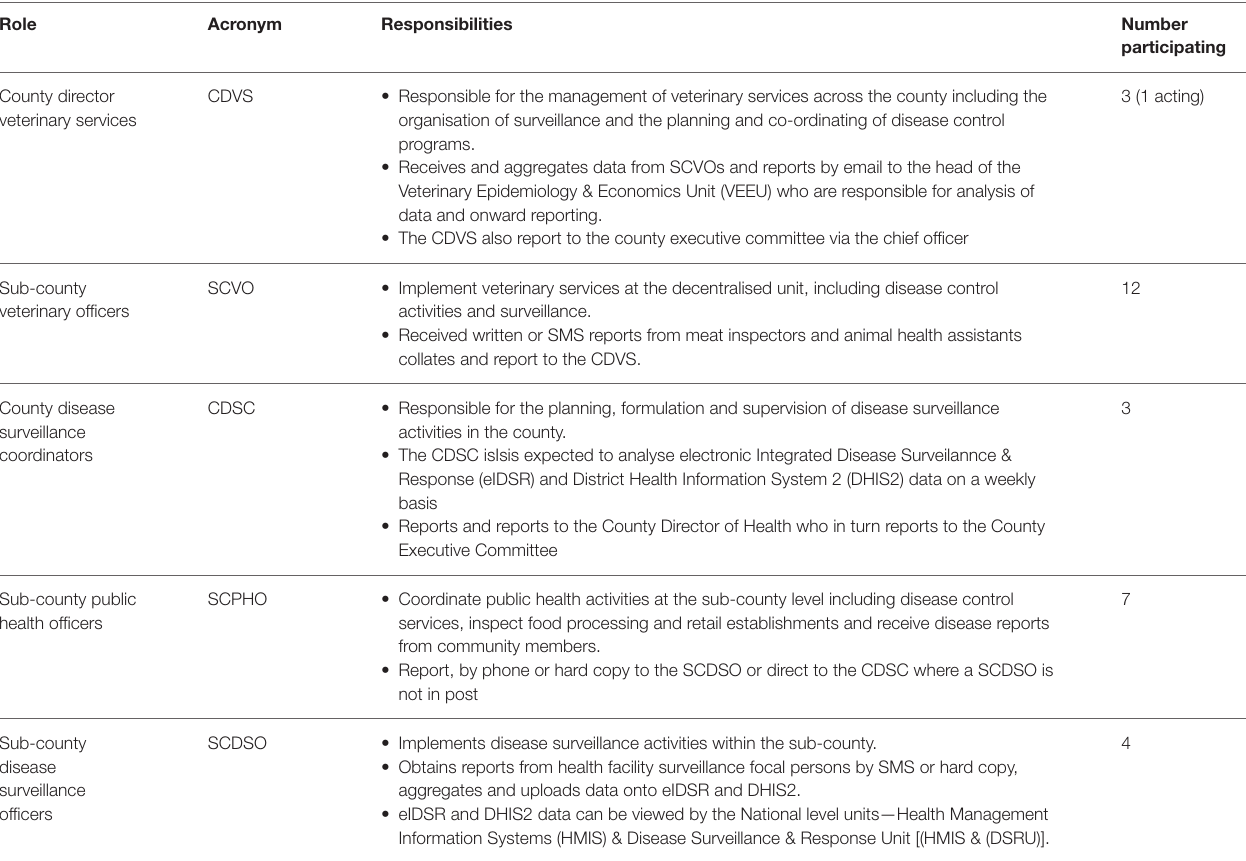
TABLE 1 | Study participants and their roles and responsibilities within disease surveillance in